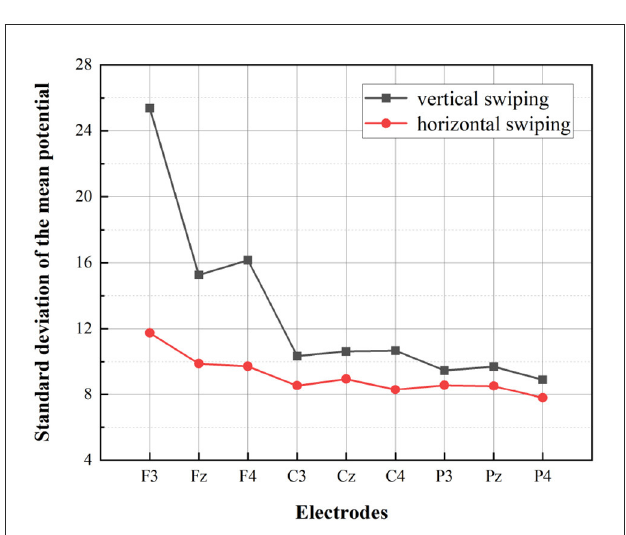
FIGURE10 Statistics for females in two swiping directions. The standard deviation of the mean potential at the different electrodes for the two swiping directions are depicted.